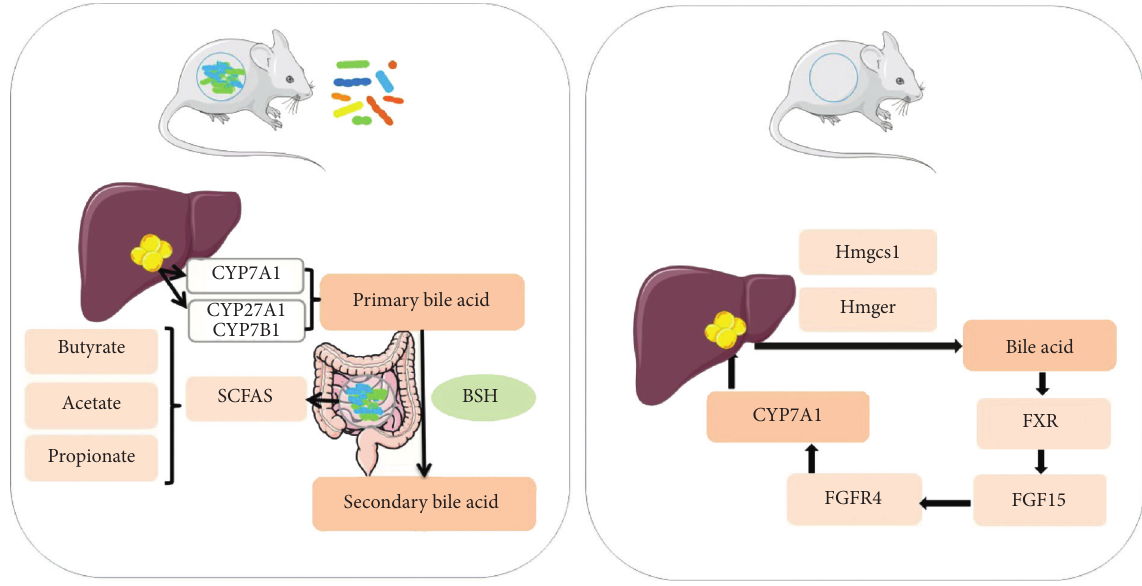
Figure 1: The metabolic pathways of gut microbiota in conventional and germ-free mice.